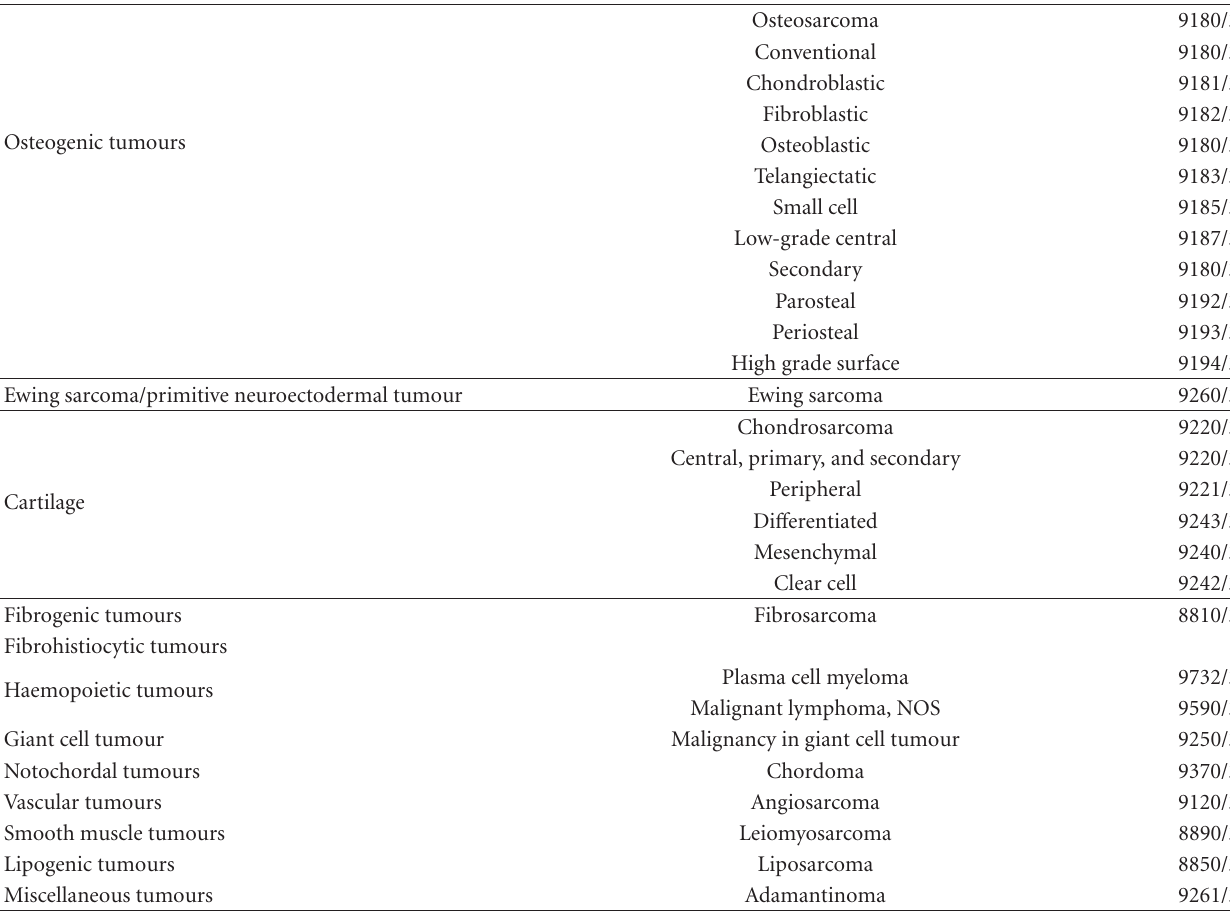
Table 1: 2002 WHO classification of malignant bone tumours